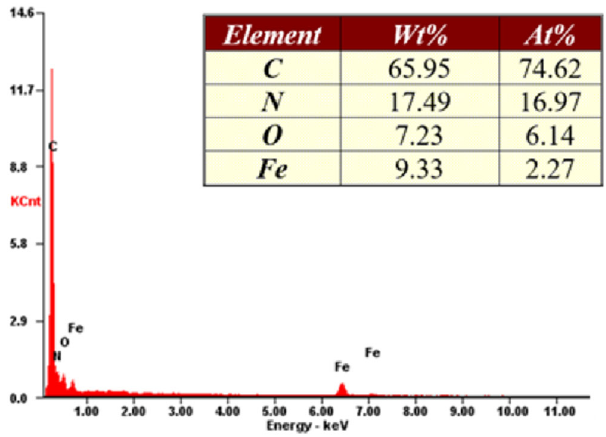
Figure 7. EDS analysis of PAN/Fe 3 O 4 fibers.